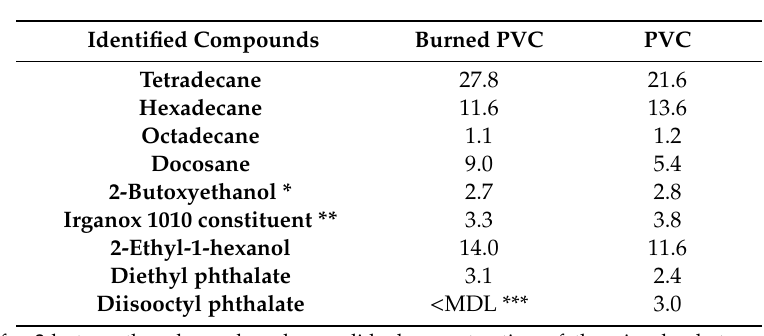
Table 1. Concentrations of contaminants in the leachates of burned and unburned polyvinyl chloride (PVC)polymer pipes shown in the units of “ppm” or “ µ g analyte per gram of pipe material”. The relative standard deviation of triplicate analysis is calculated to be in the range of 20–45% for the compounds